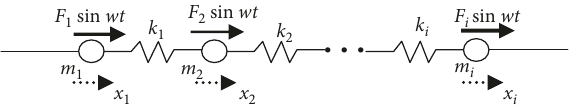
Figure 19: Equivalent undamped multi-degree-of-freedom vi- bration system for the steering